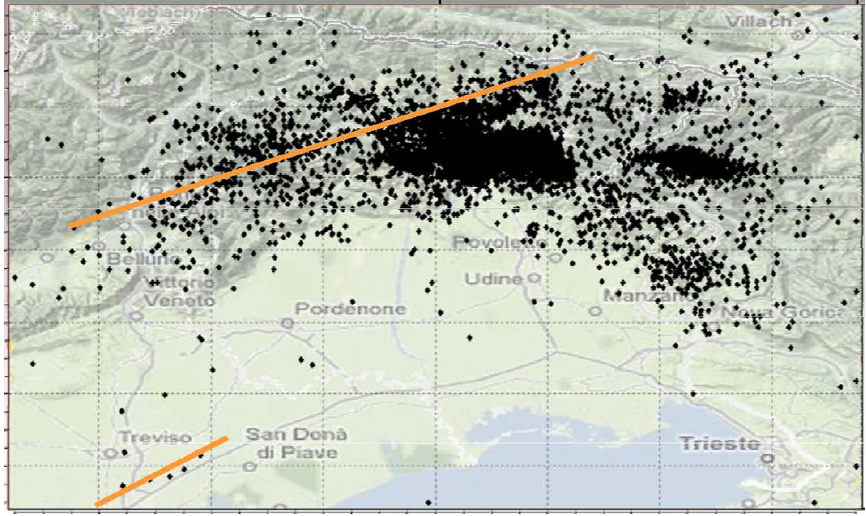
Figure 9. Epicenters estimated using the Hypo3D algorithm. The orange lines highlight patterns to be compared with the corresponding ones in Figure